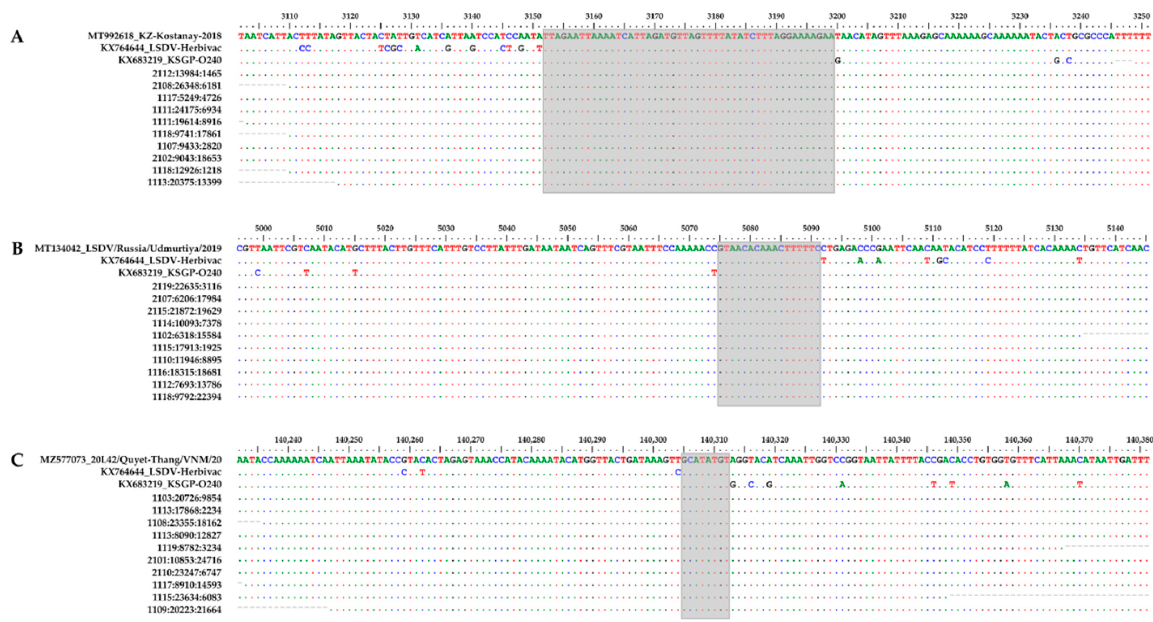
Figure 4. Individual reads covering potential recombination breakpoints. A 150 bp region contain- ing a potential recombination breakpoint in KZ-Kostanay-2018 ( A ), LSDV/Russia/Udmurtiya/2019 ( B ) or 20L42/Quyet-Thang/VNM/20 ( C ) was aligned with both parental strains and 10 reads from the B-0517_DNA dataset. Nucleotides that were identical to the top sequence are shown as dots. Positions refer to the position in the vaccine-like recombinant strain. The putative locations of the recombination breakpoints are highlighted in grey.